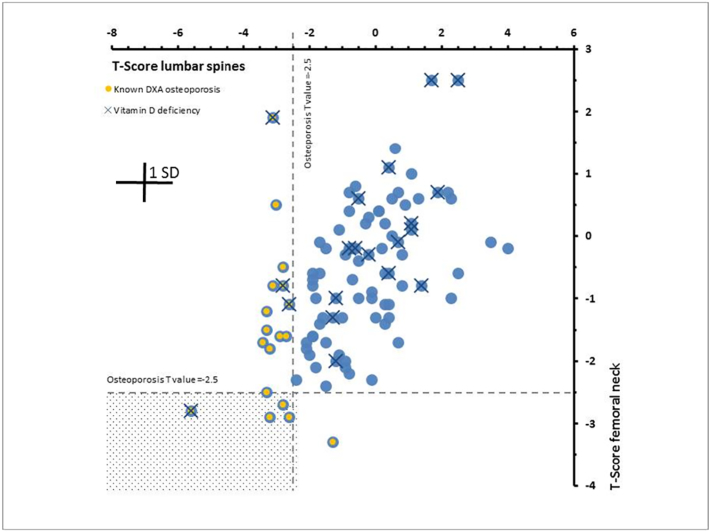
Correlations between DXA T-scores from femoral neck and lumbar spine for all 100 subjects. Broken horizontal and vertical lines represent T-score threshold values of −2.5 for the diagnosis of osteoporosis. DXA diagnosed osteoporosis and vitamin D deficiencies are marked. Osteoporosis was diagnosed in total of 18 cases. Only in 5 cases osteoporosis was diagnosed based on T-score values of both, femoral neck and lumbar spine (marked area). Only in one case osteoporosis is based on the femoral neck alone and in 12 cases lumbar spines alone indicated osteoporosis.